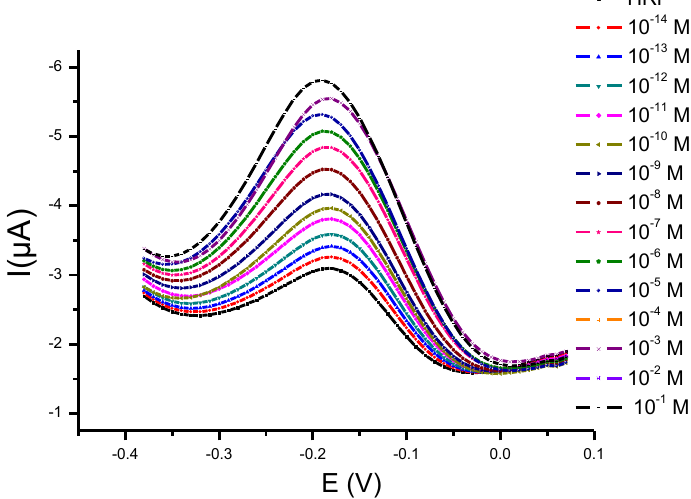
Figure 7. SWV voltammograms for different OTA concentrations. All measurements are recorded in 0.1 M of PBS with 1 mM H 2 O 2 .